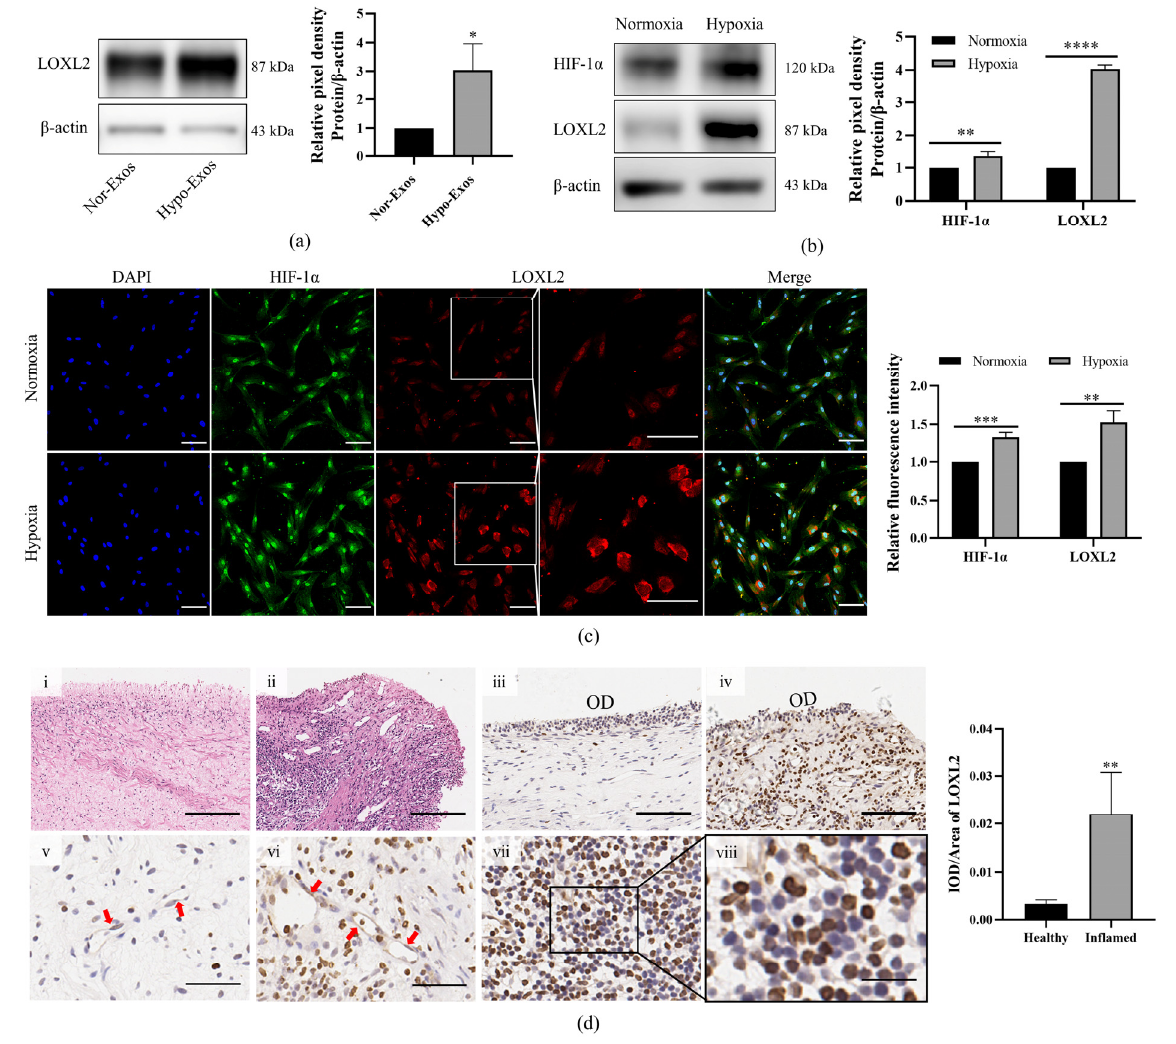
Figure 7. Protein expression of LOXL2 in DPSC-Exos, DPSCs and dental pulp tissue. ( a ) Detection of exosomal protein levels of LOXL2 in normoxia and hypoxia-preconditioned DPSCs by Western blot analysis. ( b ) Protein expression of HIF1 α and LOXL2 in DPSCs under normoxia or hypoxia by Western blot. ( c ) Immunofluorescence images of HIF1 α (green) and LOXL2 (red) in DPSCs under normoxia or hypoxia. Nuclei were stained with DAPI (blue). ( d ) Immunolocalization of LOXL2 in healthy and inflamed human dental pulp tissues. Healthy ( d-i ) and inflamed ( d-ii ) dental pulp stained with hematoxylin-eosin. Positive staining of LOXL2 in the odontoblast layer (OD) of healthy pulp ( d-iii ) and inflamed pulp ( d-iv ). Positive staining of LOXL2 in endothelial cells (red arrow) of healthy pulp ( d-v ) and inflamed pulp ( d-vi ). ( d-vii ) Intense staining of inflammatory cells in inflamed pulps. n = 3 ( a – c ), n = 4 ( d ), mean ± SD, * p < 0.05, ** p < 0.01, *** p < 0.001, **** p < 0.0001. Scale bars: 200 µ m ( d-i , d-ii ); 100 µ m ( c , d-iii , d-iv ); 50 µ m ( d-v , d-vi ); 20 µ m ( d-viii ). It is known that LOXL2 regulates the angiogenesis of endothelial cells (ECs).